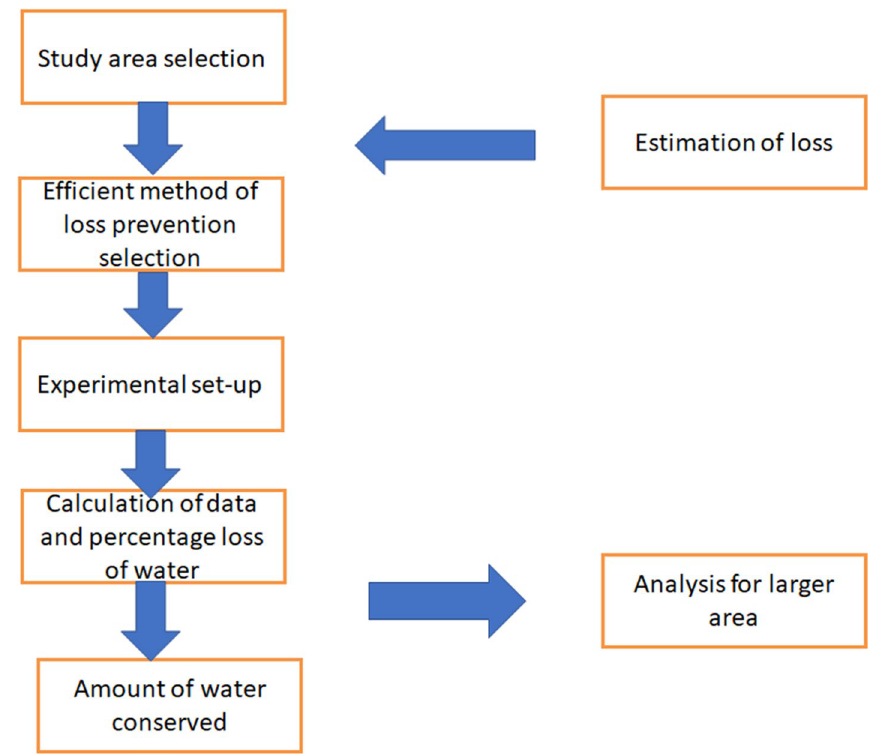
Fig. 1 Methodology adopted